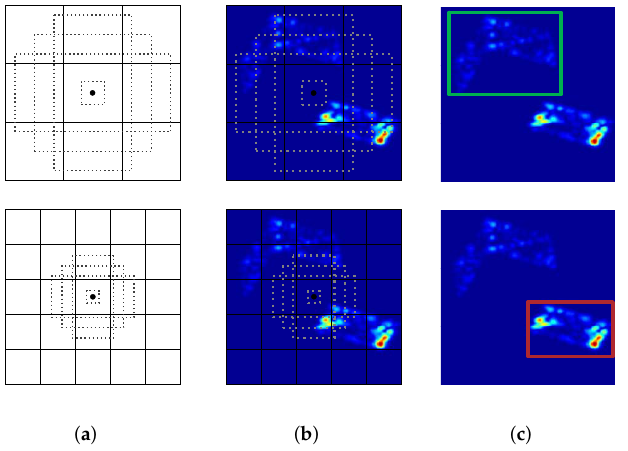
Figure 6. Different scale detection. ( a ) Different scale feature maps: 3 × 3 and 5 × 5, ( b ) prediction procedure, ( c ) detection result.